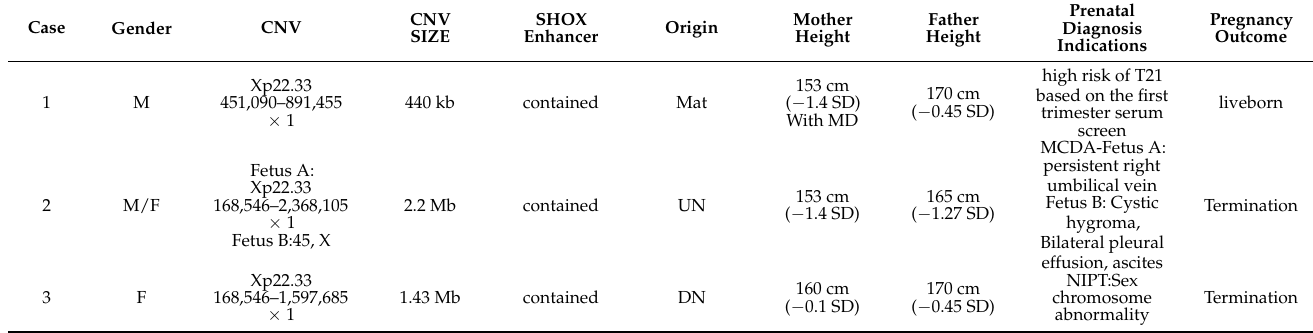
Table 1. Summary of SHOX haploinsufficiency cases. Parent measurements of height are given in